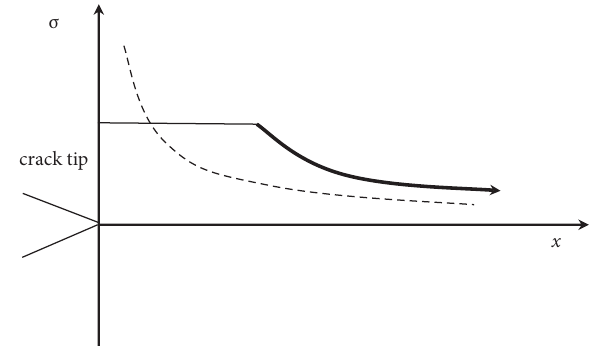
Figure 1: Stress distribution in front of the crack